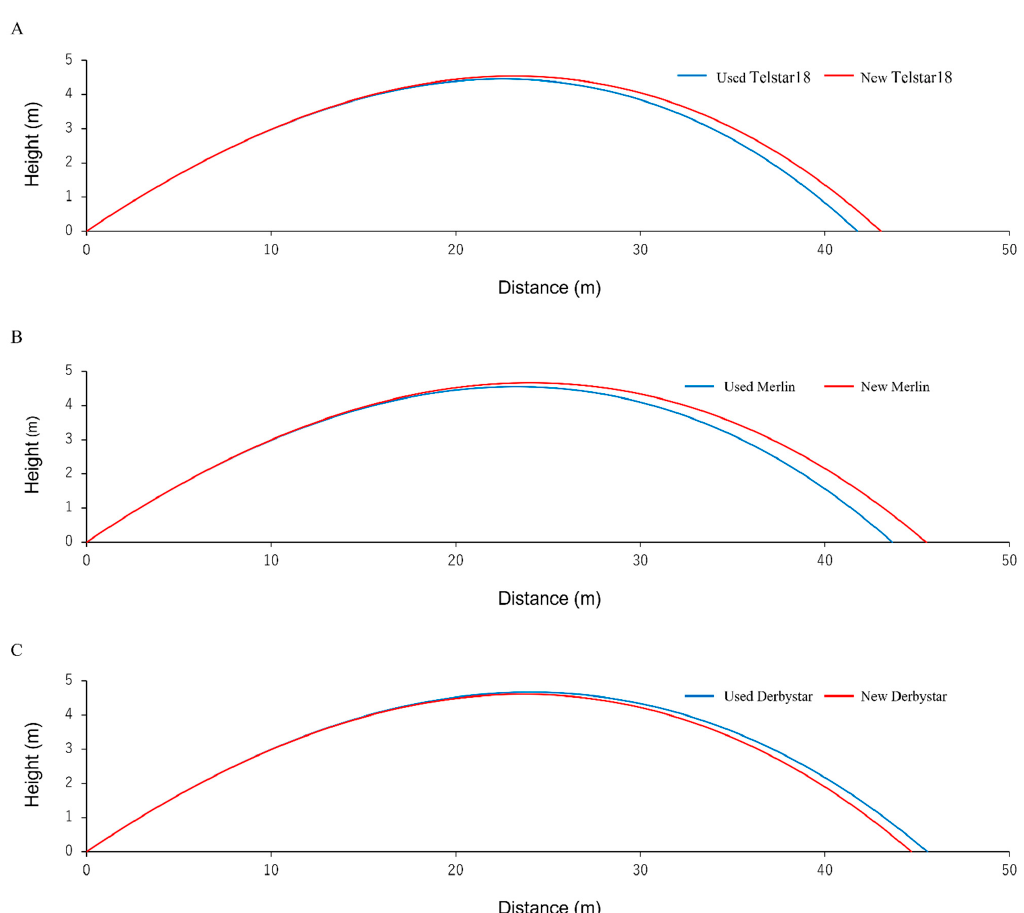
Figure 6. Comparison of the flight trajectories of the soccer balls (initial speed 30 m/s, release angle 20°) ( A – C ) show the results for Telstar18, Merlin, and Derbystar, respectively. Appl. Sci. 2021 , 11 , 7204 Figure 7 shows the trajectories of the soccer balls when kicked from the starting point (0 m) to the impact point (height) with the net at 20 m. The trajectories were estimated using an initial speed of 20 m/s and a release angle of 15°. For Telstar18, the heights of the trajectories at the impact point of the new and used balls were 1.48 m and 1.42 m, respec- tively. For the new and used Merlin, the corresponding values were 1.63 m and 1.54 m, respectively. For the new and used Derbystar, the corresponding values were 1.61 m and 1.64 m, respectively.